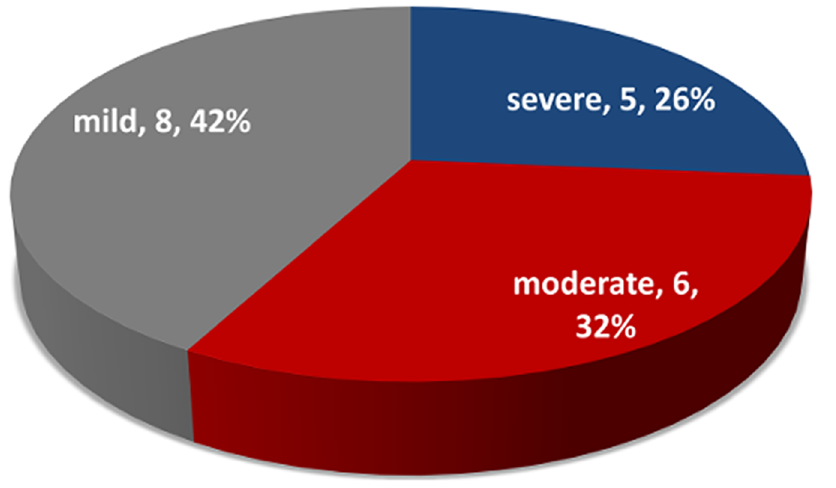
Fig 1. Severityof depression among respondents.